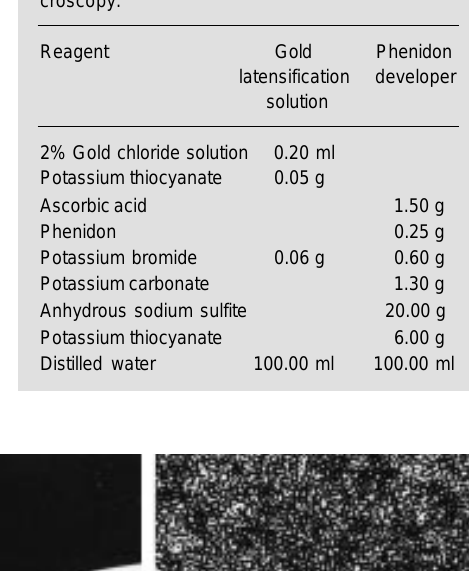
Table 2 - Fine grain developers for electron mi- croscopy.